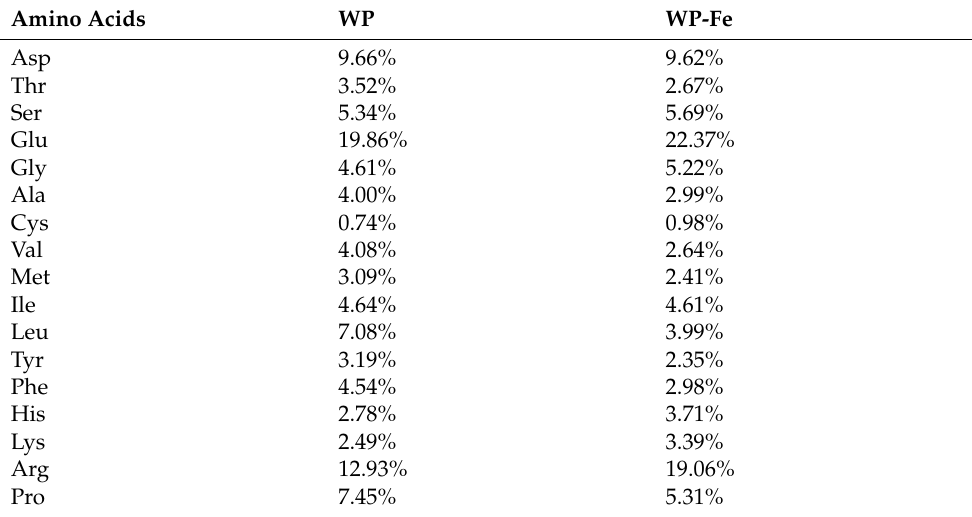
Table 1. Amino acid compositions of the WP and the WP-Fe chelate.